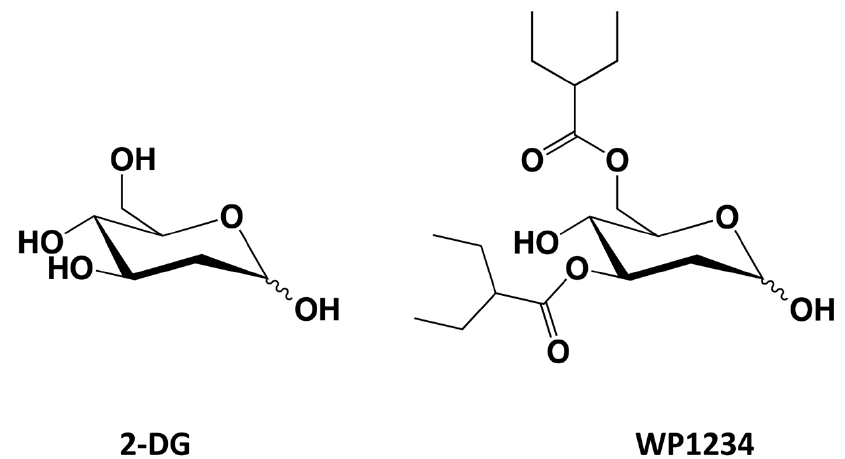
Figure 1. Chemical structures of 2-DG and WP1234.